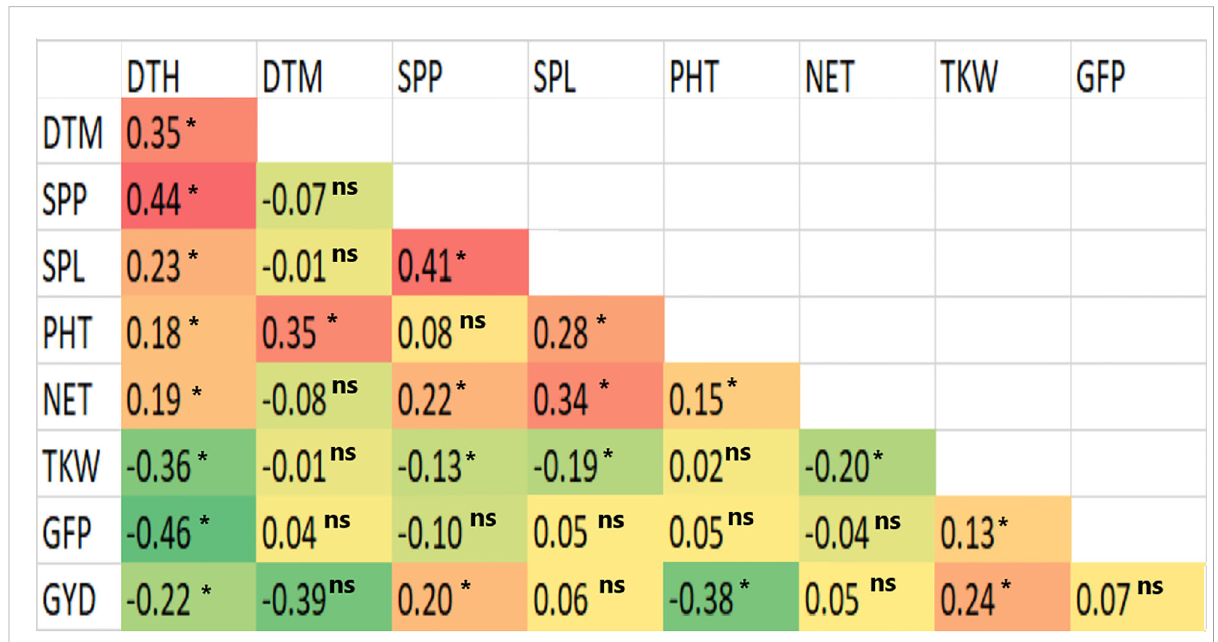
FIGURE 2 Computed correlation plots between pairs of phenotypic traits based on the best linear unbiased estimators of the nine traits measured in 420 durum wheat genotypes. N.B. *refers to signi fi cant at p< 0.01 , and ns refers to non-signi fi cant at p<